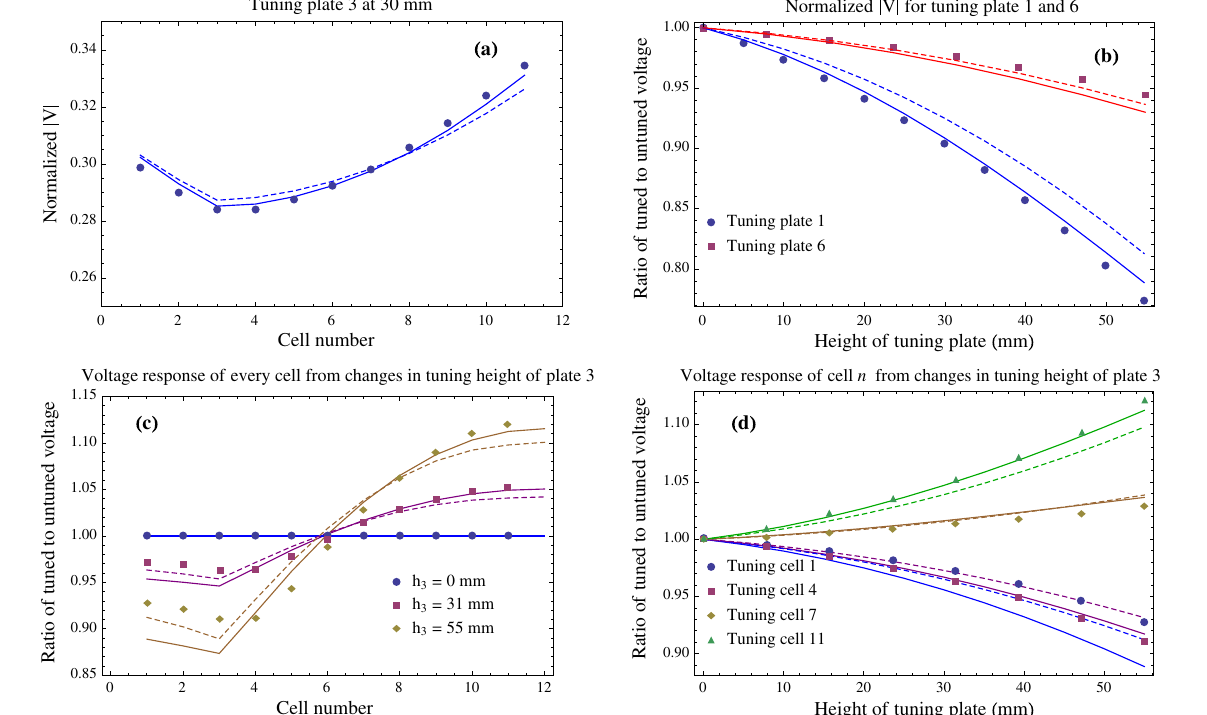
FIG. 12 (color online). All the curves have been calculated using the parameters shown in Table I and the filled dots, filled squares, etc. come from MWS. All the continuous curves come from numerically solving Eq. (4) and the dashed curves come from perturbation theory solutions described in Sec. IIB3. (a) The relative field flatness when tuning plate 3 is at 30 mm while the rest are at 0 mm. (b) The relative voltage in tuning cells 1 and 6 when their tuning plates are moved. (c) The relative field flatness of all the cells when the tuning plate in cell 3 is set to 31 and 55 mm. The predicted curves are good for tuning cells 4 to 11. Interestingly, the perturbative solution matches the MWS data better than the numerical eigensystems solution. (d) The relative voltage response of tuning cells 1, 4, 7, and 11 when tuning plate 3 is moved. The predicted curves using the numerical eigensystems method match the MWS data very well except for cell 1, while the perturbative solution does not do as well.